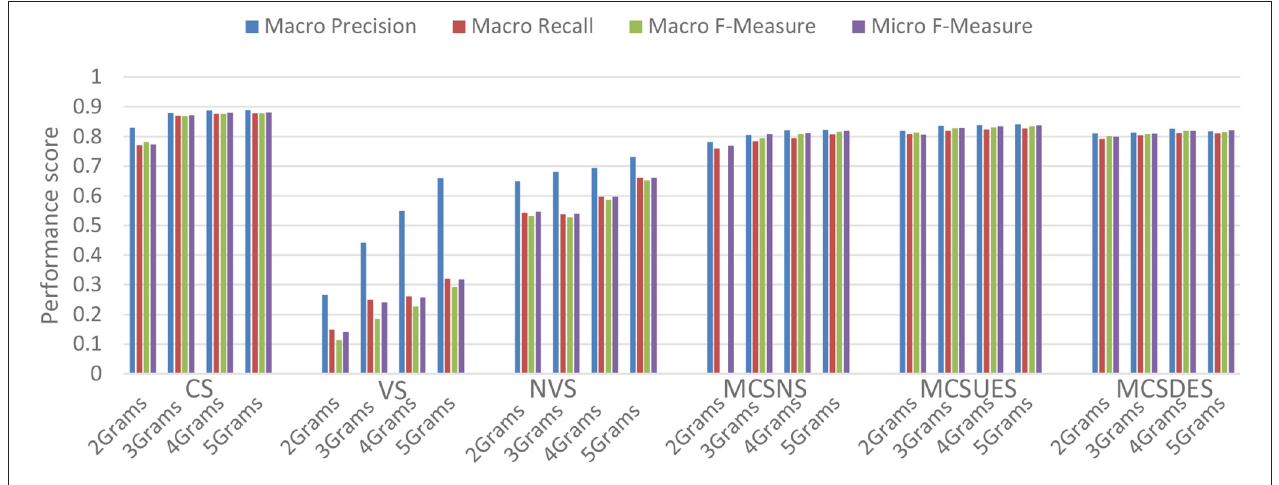
FIGURE 7 | Evaluating graph similarity metrics with